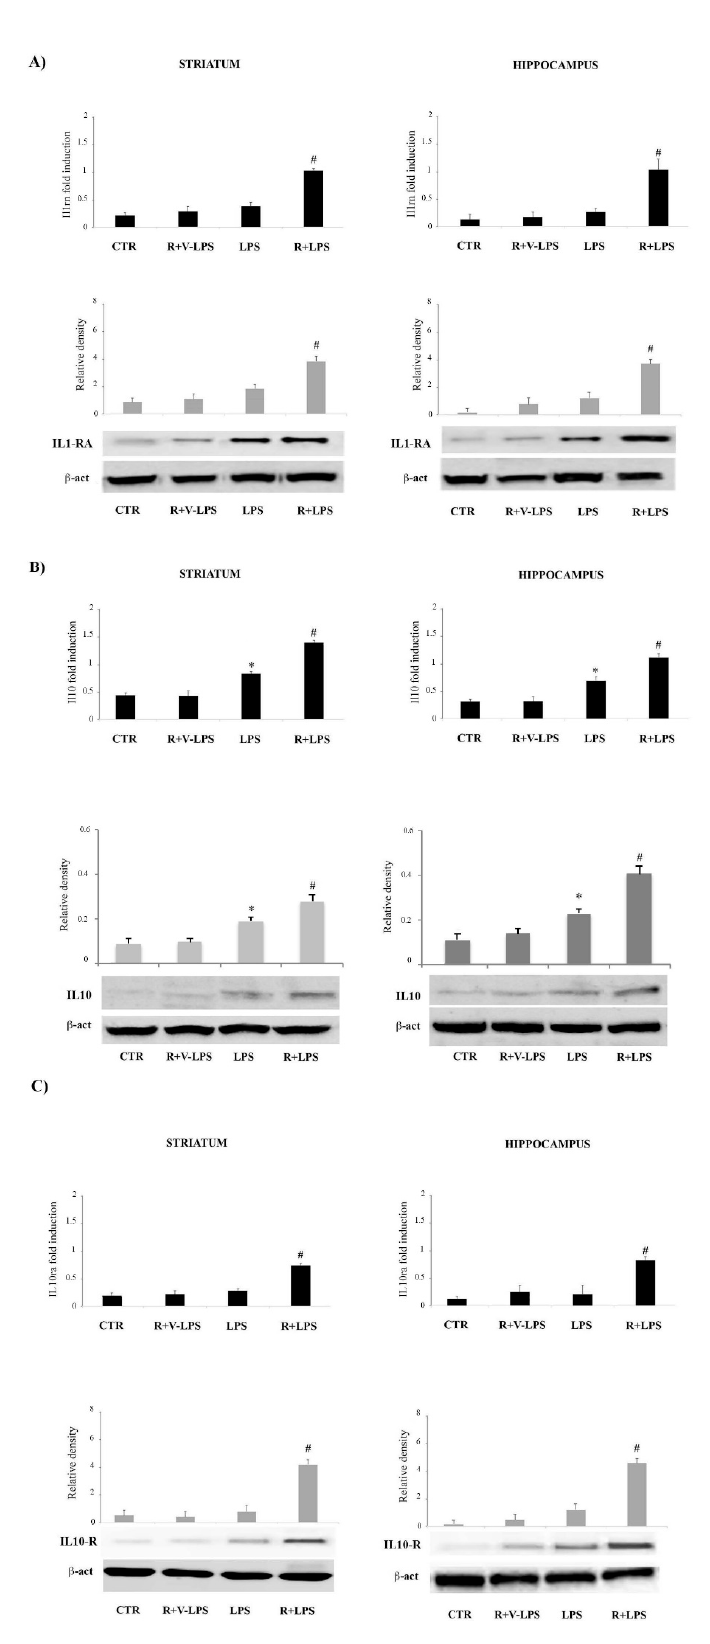
Figure 4. Real-time PCR analysis, Western blotting detection, densitometric analysis of ( A ) IL-1 receptor antagonist Il1rn mRNA and protein (IL1-RA) expression and ( B ) Il10 mRNA and protein (IL10) and ( C ) Il10ra mRNA and protein